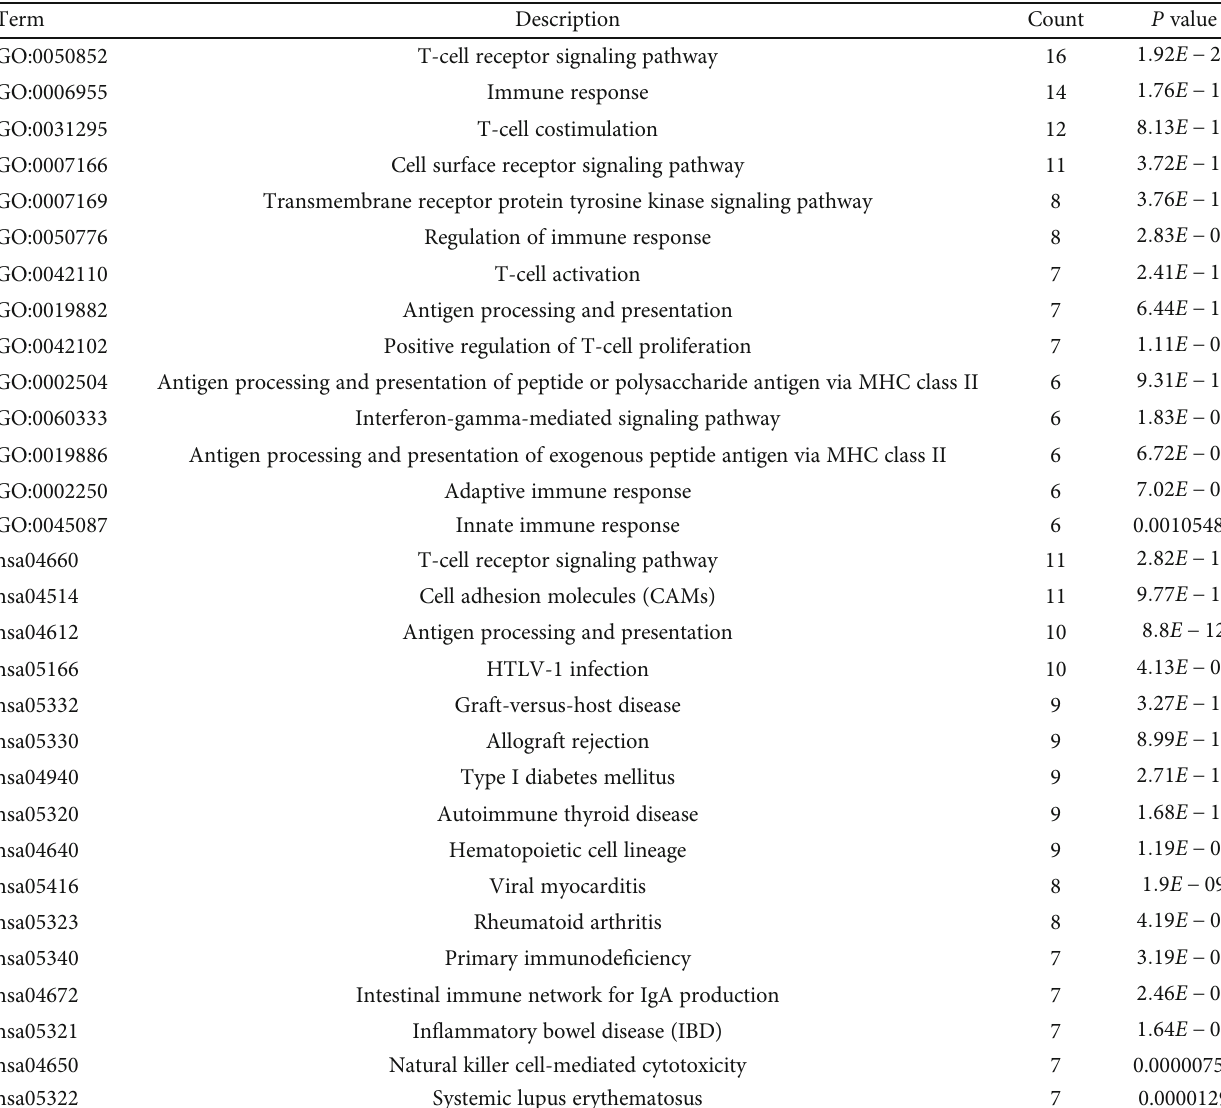
(a) Functions enriched for the genes involved in cluster A